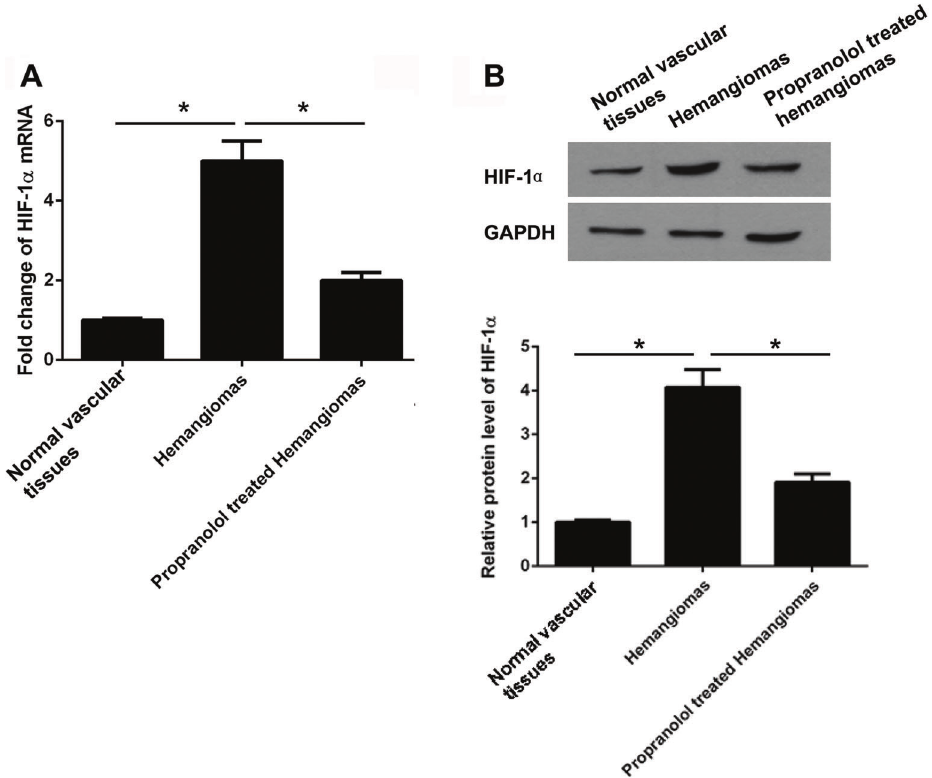
Figure 1. A , Expression of hypoxia inducible factor-1 a (HIF-1 a ) mRNA determined by RT-qPCR. Data are reported as fold of control. B , Expression of HIF-1 a protein level determined by western blotting. Data (lower panel) are reported as the average absorbance of HIF-1 a protein of three independent experiments. *P o 0.05